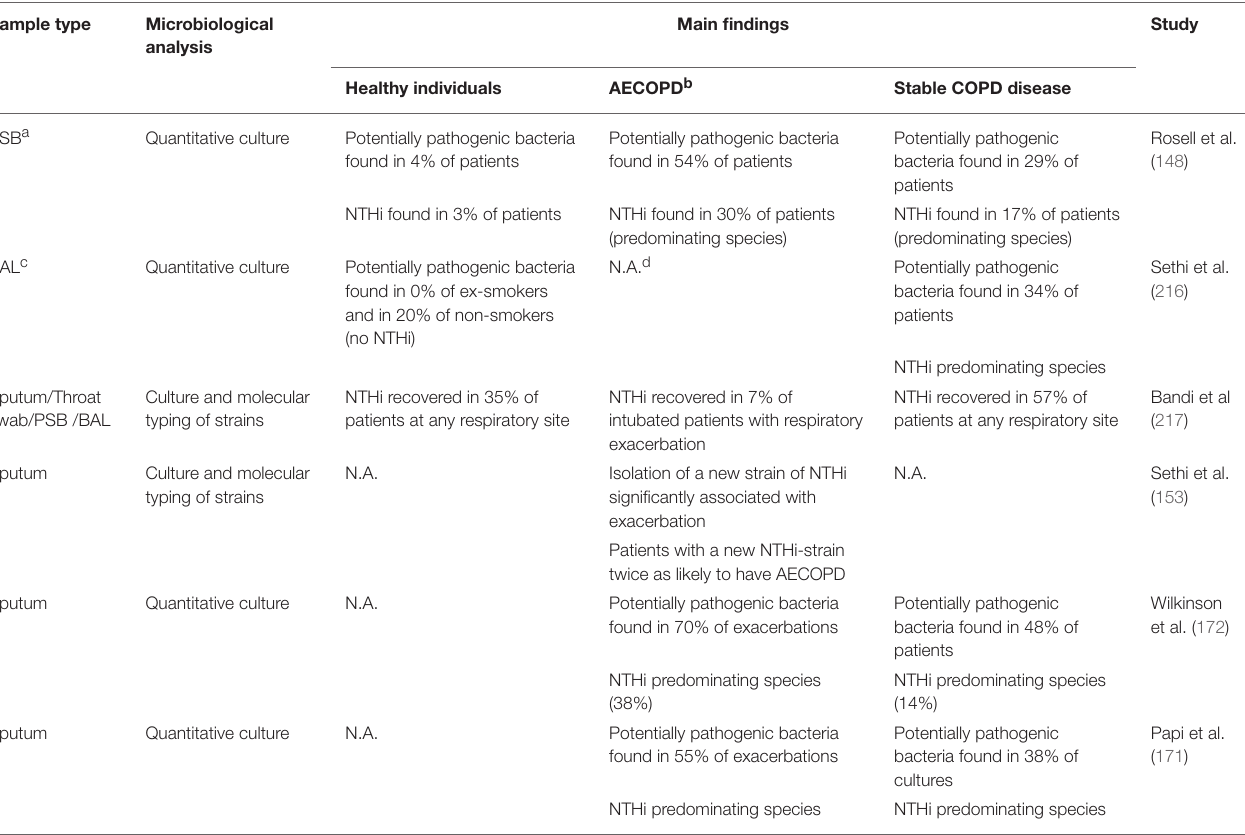
TABLE 1 | Abundance and significance of NTHi and other potentially pathogenic bacteria in healthy individuals and various stages of COPD using culture-based methods. Sample